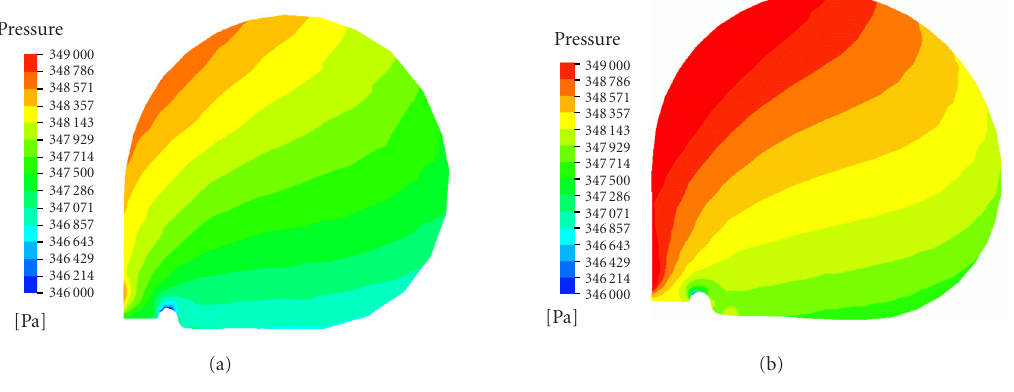
Figure 10: Static pressure contours at volute exit ( θ = 360 ◦ ), showing similar results as in Figure 9. (a) Sharp tongue. (b) Round tongue.